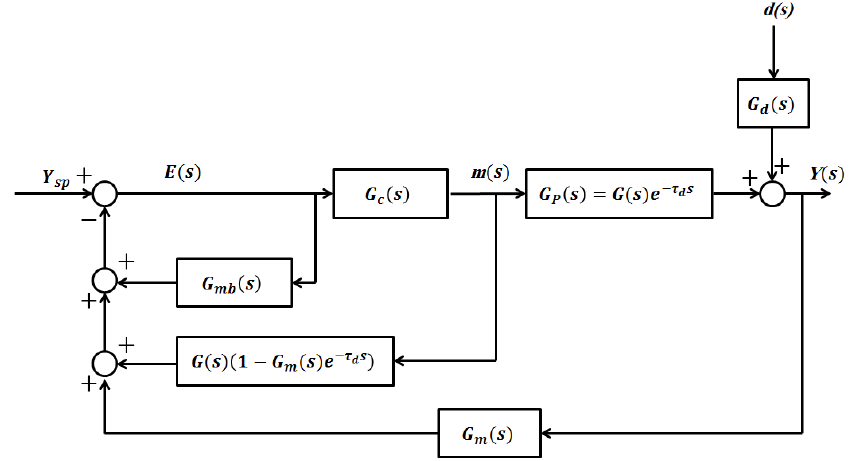
Figure 2. Open-loop equations of the system with the addition of the dominant gain transfer function. It is assumed that the measurement transfer function is equal to 1 ( G m ( s ) = 1). The closed-loop transfer functions of this system are in the form of relations (1) and